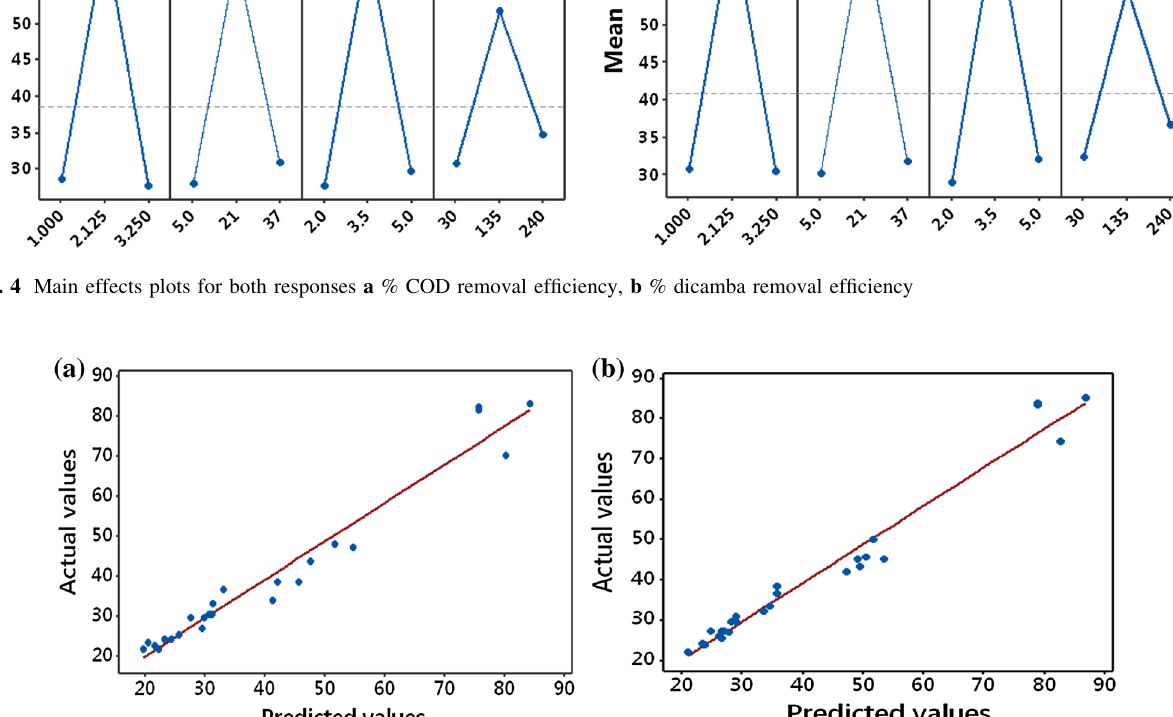
Contour overlay plot for validation To find out the optimum region or working feasible region for Fenton’s process, the contour plots were overlaid graphically, where all the variables meet simultaneously in a particular area (Ahmad et al. 2005). In this optimization